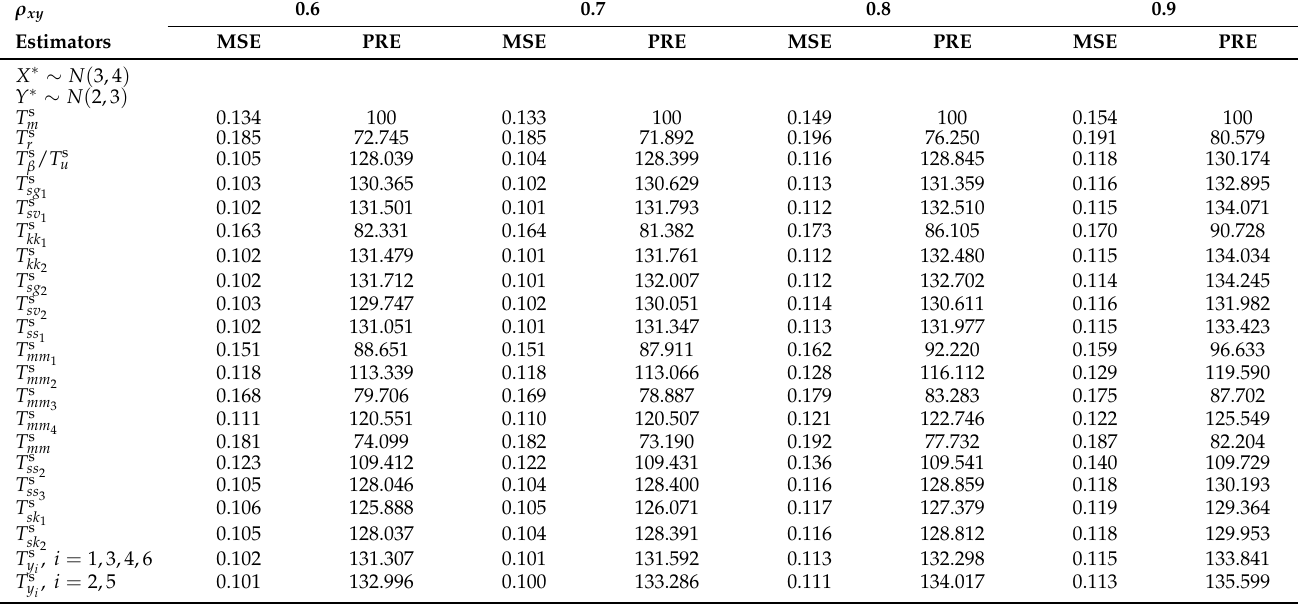
Table 7. MSE and PRE of separate estimators utilizing hypothetically drawn Normal population.